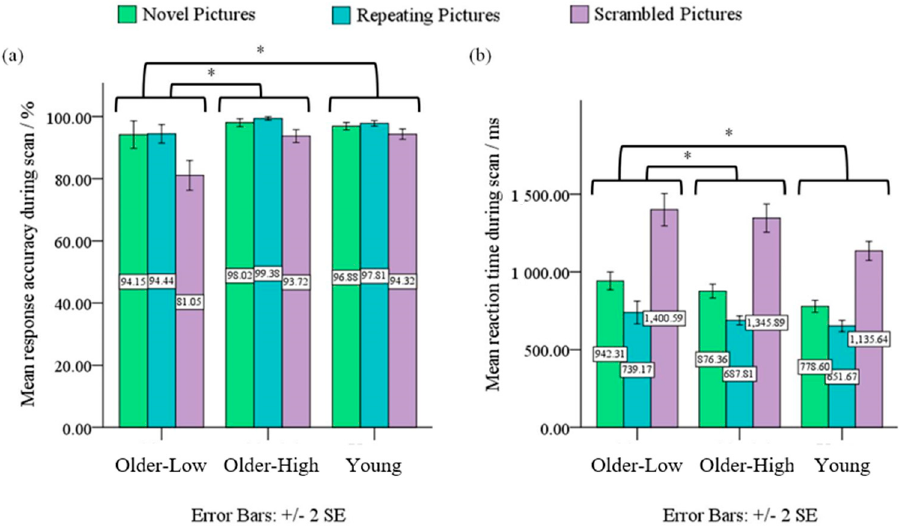
Figure 3. ( a ) Performance × condition mixed design ANOVA on ACC revealed signi fi cant interaction e ff ect, main e ff ects of performance and condition, at p < 0.05. ( b ) Performance × condition mixed design ANOVA on RT revealed signi fi cant interaction e ff ect, main e ff ects of performance and con- dition, at p < 0.05